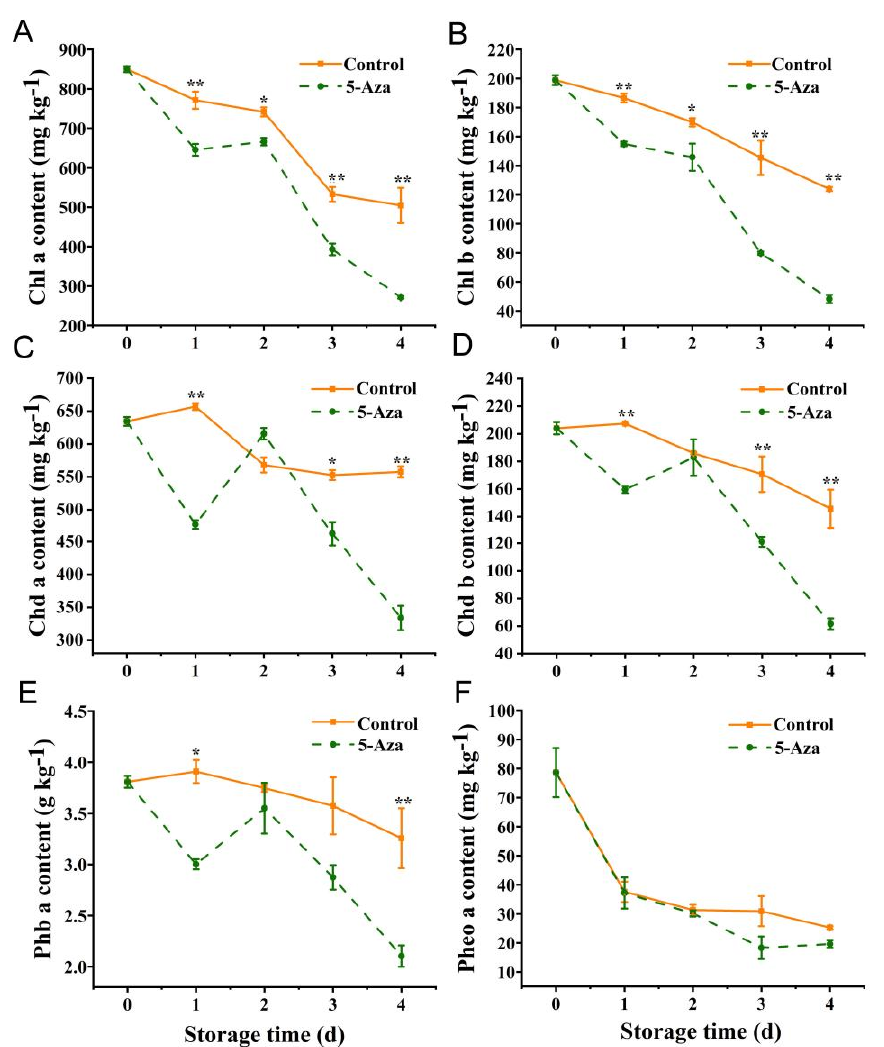
Figure 5. Chl a ( A ), Chl b ( B ), Chd a ( C ), Chd b ( D ), Phb a ( E ), Pheo a ( F ) contents of pak choi in the treatment and control groups at 20 ± 1 °C. The data in the figure are the mean ± SD of three biological replicates. The asterisks in the figure indicate significant differences between the mean values of treatments and controls (* p < 0.05; ** p < 0.01).